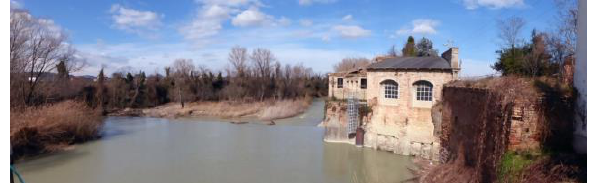
Figure 2. A current photo of the Cento sluice